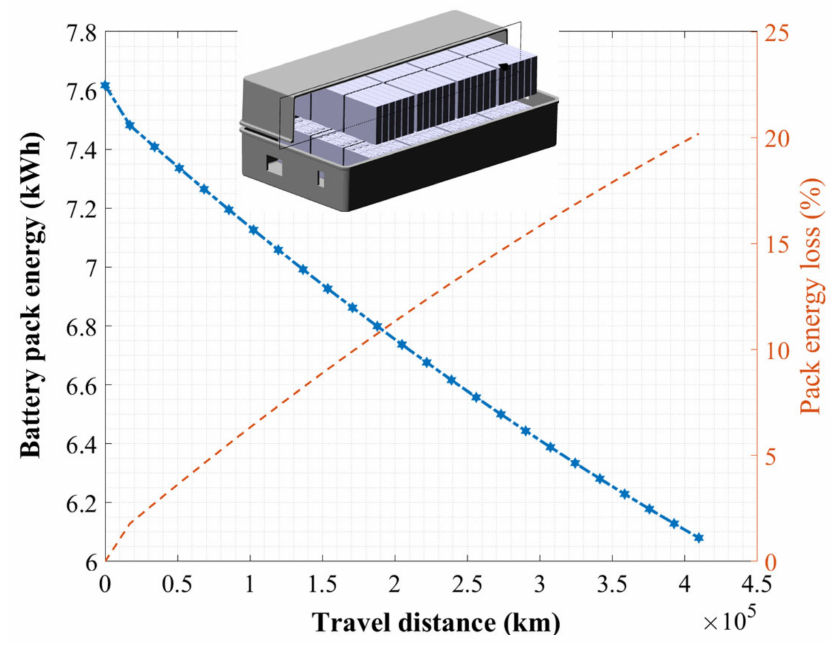
Figure 5. Pack-level lifetime simulation for the whole first life at ambient 25 ◦